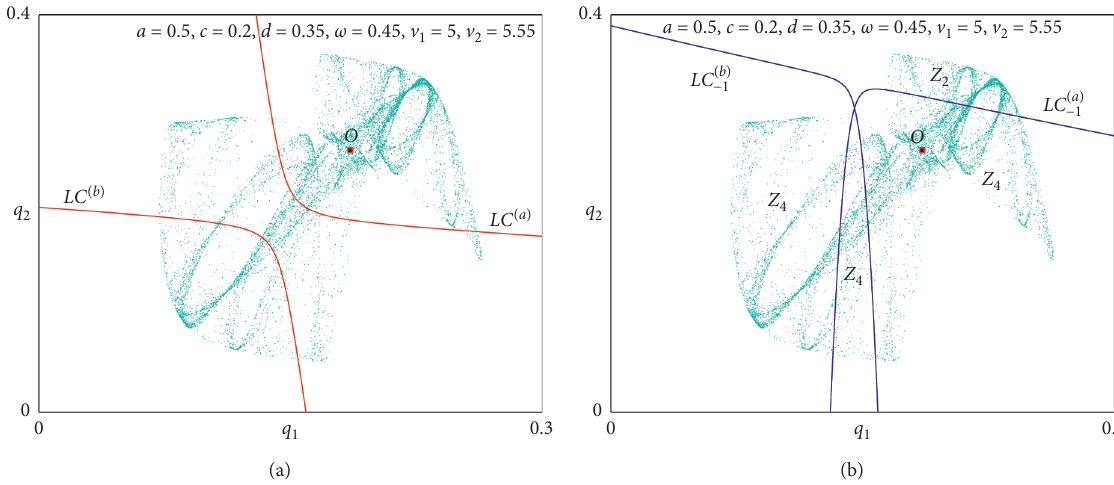
Figure 5: (a), (b) The critical curves LC, LC � 5 . and ] 2